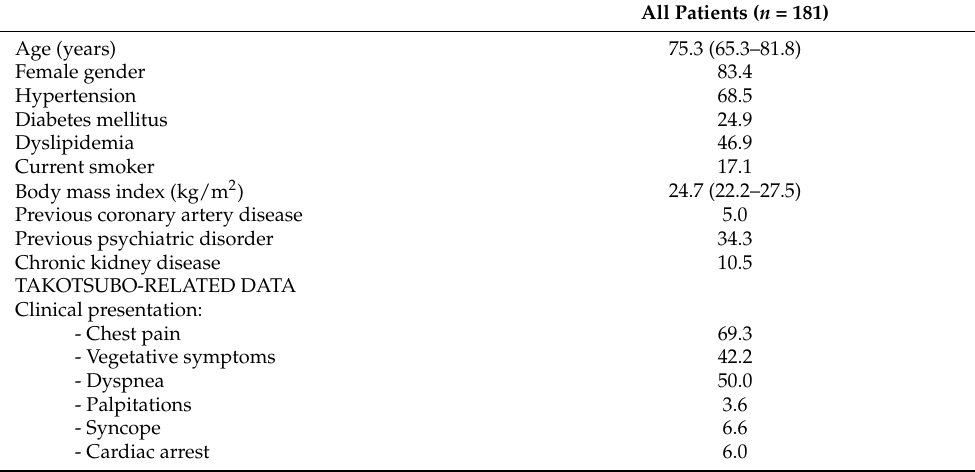
Table 1. Clinical, ECG, biochemical, echocardiographic and therapeutic characteristics of the study population at